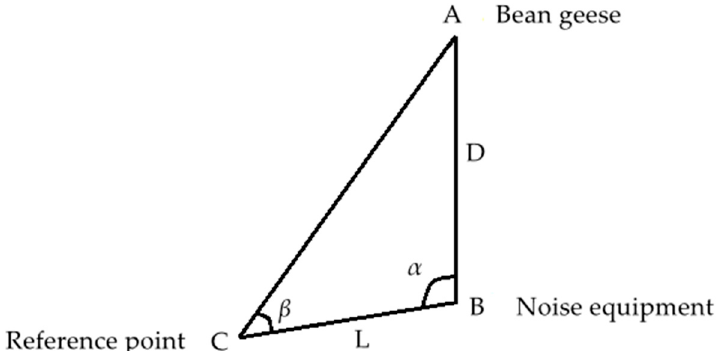
Figure 1. Schematic diagram of the distance between the bean geese and the noise source.